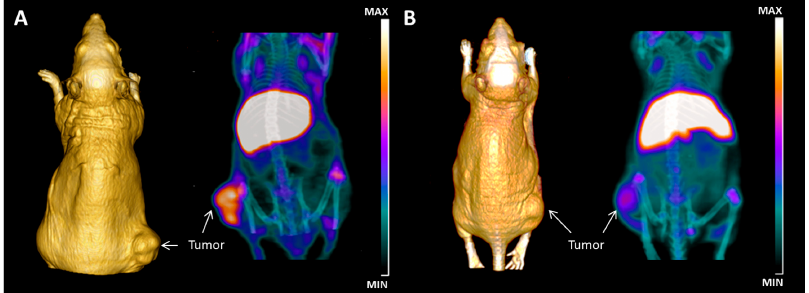
Figure 3. In vivo immuno-positron emission tomography (immuno-PET) imaging of thyroid tumor by targeting galectin-3 . ( A ) Maximum intensity projection (MIP) of μ -PET images acquired at 48 h post-injection of 40 μ Ci of radiotracer showing accumulation of 89 Zr-labelled mAb to gal-3 in subcutaneous tumor growing in the right thigh. 3D volume rendering (3D VR), based on CT acquisition performed using OsiriX Image Software 5.0 (Pixmeo, Geneva, Switzerland), allows a tri- dimensional reconstruction of the anatomy of the mouse and visualization of the tumor shape. The activity in the liver is due to residualization of antibody metabolites. ( B ) A strong reduction of uptake is visualized in mice pre-injected with 100-fold excess of unlabeled mAb to gal-3 and imaged 48 h post-injection of the radiotracer, confirming the binding specificity. Normal thyroid gland does not express detectable galectin-3, and as expected, no accumulation of the radiotracer was visible in the neck